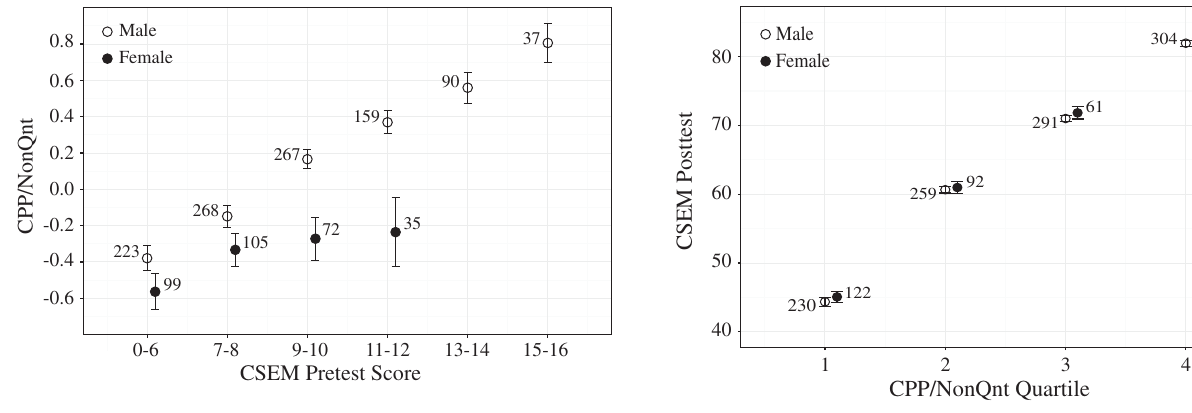
FIG. 7. CPP/NonQnt quartile vs CSEM post-test score.